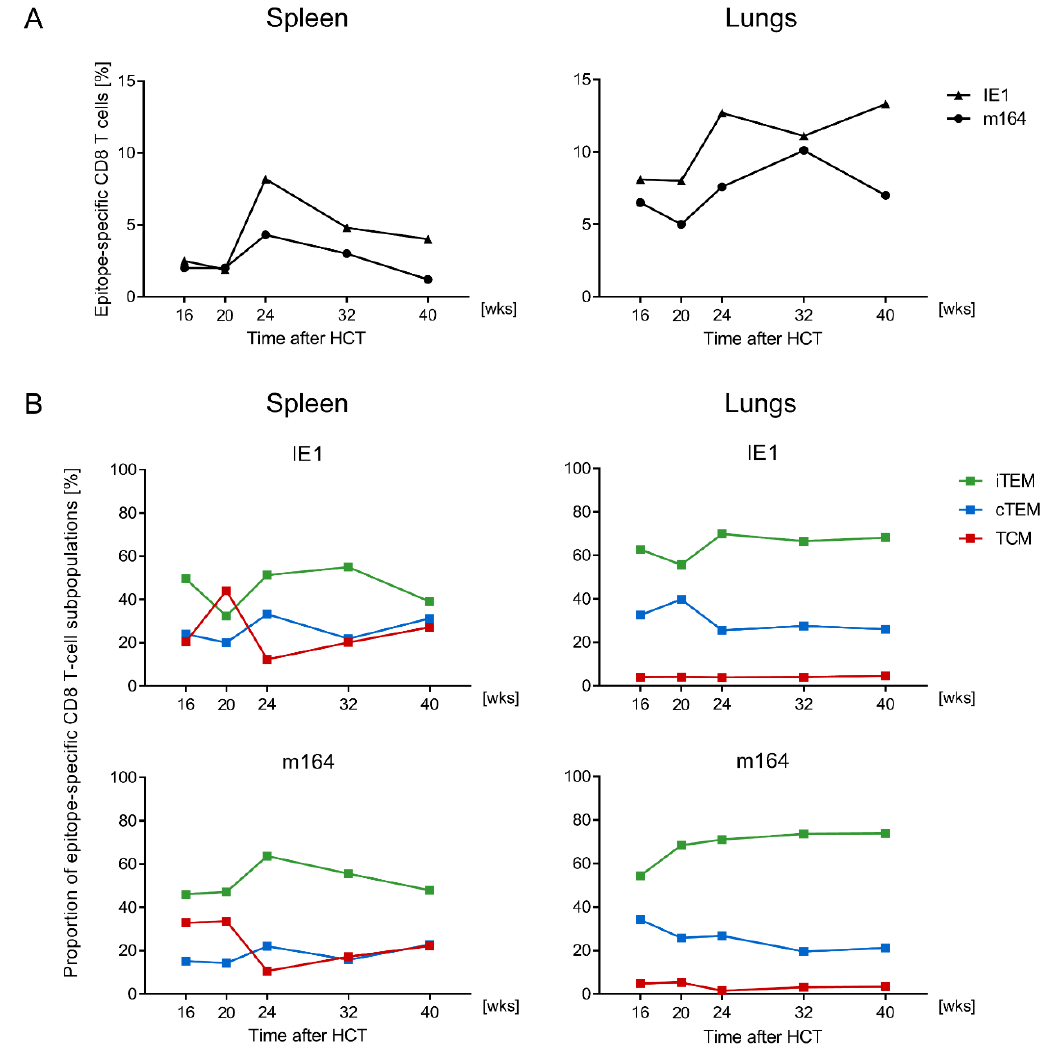
Figure 5. Kinetics of the viral epitope-specific CD8 T-cell response in the HCT model of MI. At the indicated times after HCT and intraplantar infection with 10 5 PFU of mCMV, CD8 T cells were isolated from spleen and lungs (pool of 5 organs per time of assay) of the HCT recipients. ( A ) Time course of the response to MI-driving epitopes IE1 and m164. ( B ) Corresponding dynamics of memory CD8 T-cell populations iTEM (green symbols), cTEM (blue symbols), and TCM (red symbols).